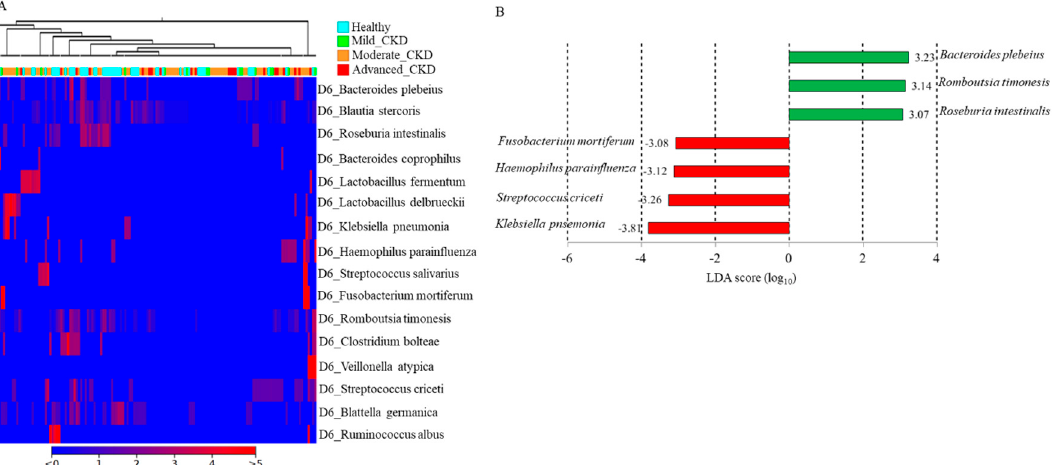
Figure 6. Identified OTU at the species level differed in the abundances between healthy participants and chronic kidney disease (CKD) patients. ( A ) Correlations between the differential abundances of the top 16 classified OTUs at the species level and all recruited participants are shown in a heat map chart. ( B ) Histogram of linear discriminant analysis (LDA) scores computed for OTUs with differential abundances in healthy participants (green bar) and CKD patients (red bar).